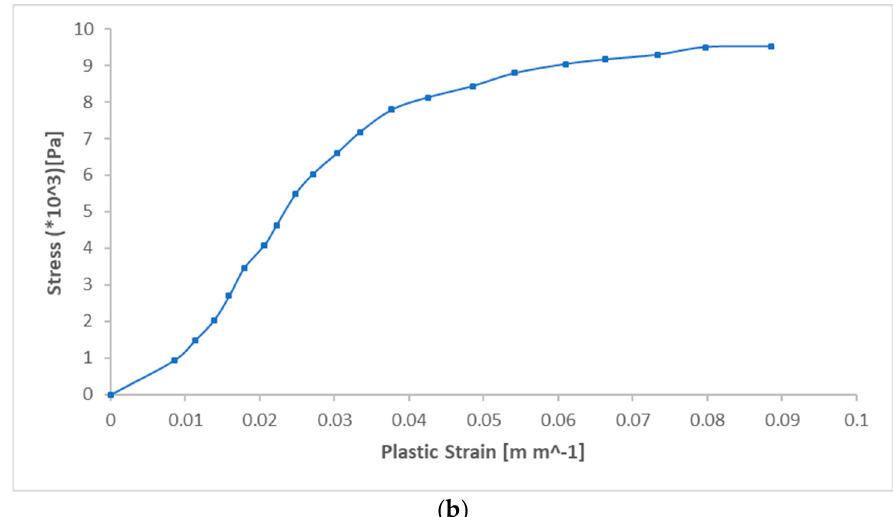
Figure 15. ( a ) Input stress–strain relationship curve of soil layer 1 for the software ANSYS. ( b ) In- put stress–strain relationship curve of soil layer 2 for the software ANSYS.